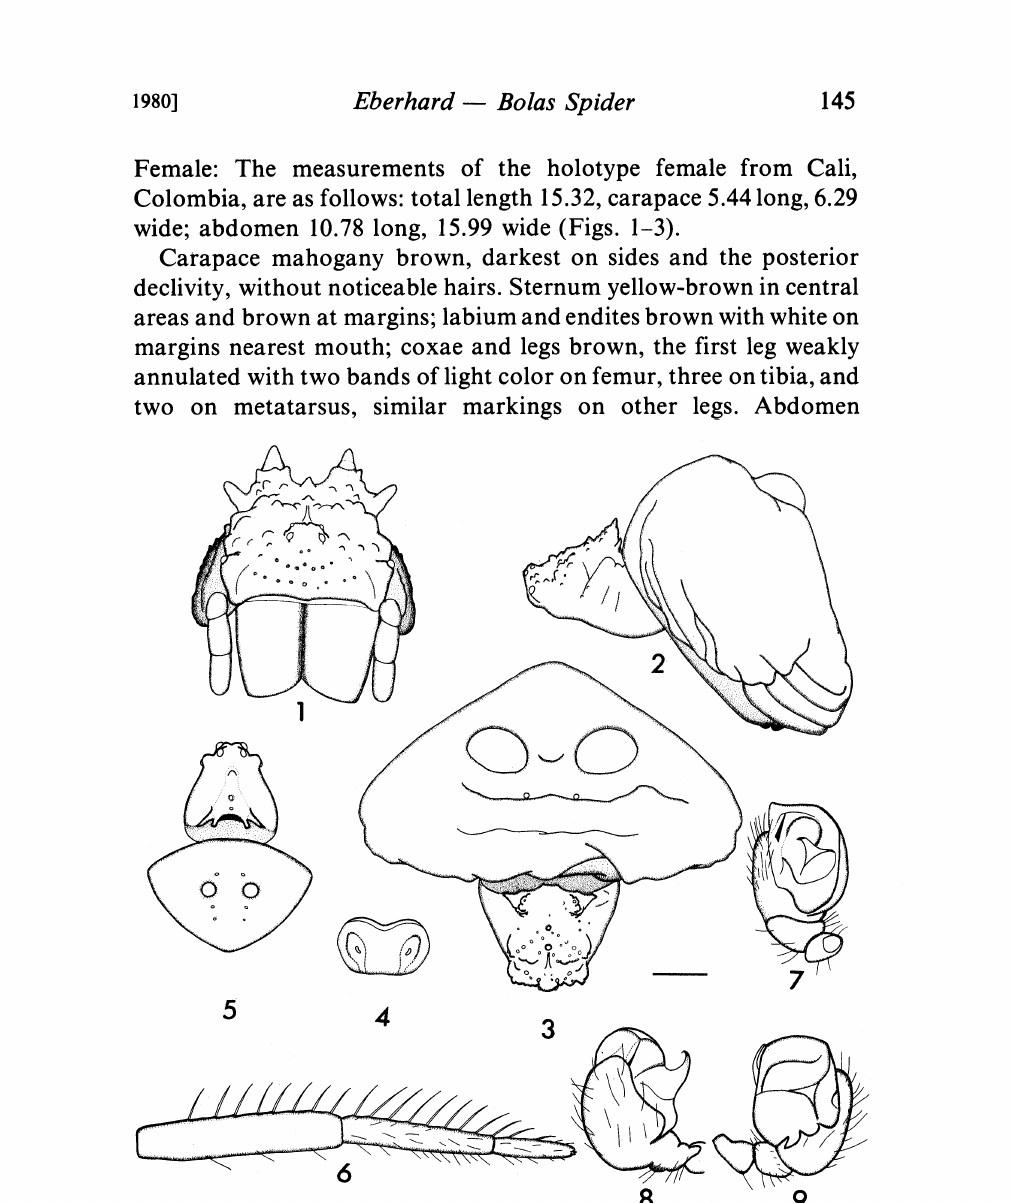
Figs. 1-9. Mastophora dizzydeani new species. 1. Female cephalothorax, anterior view without appendages. 3. Female, dorsal view without appendages. 2. Female, lateral view without appendages. 4. Epigynum, subcaudal view. 5. Male, dorsal view without apperidages. 6. Male, right leg dorsal view. 7-9. Male palpus. 7. Ventral view. 8. Lateral view. 9. Dorsal